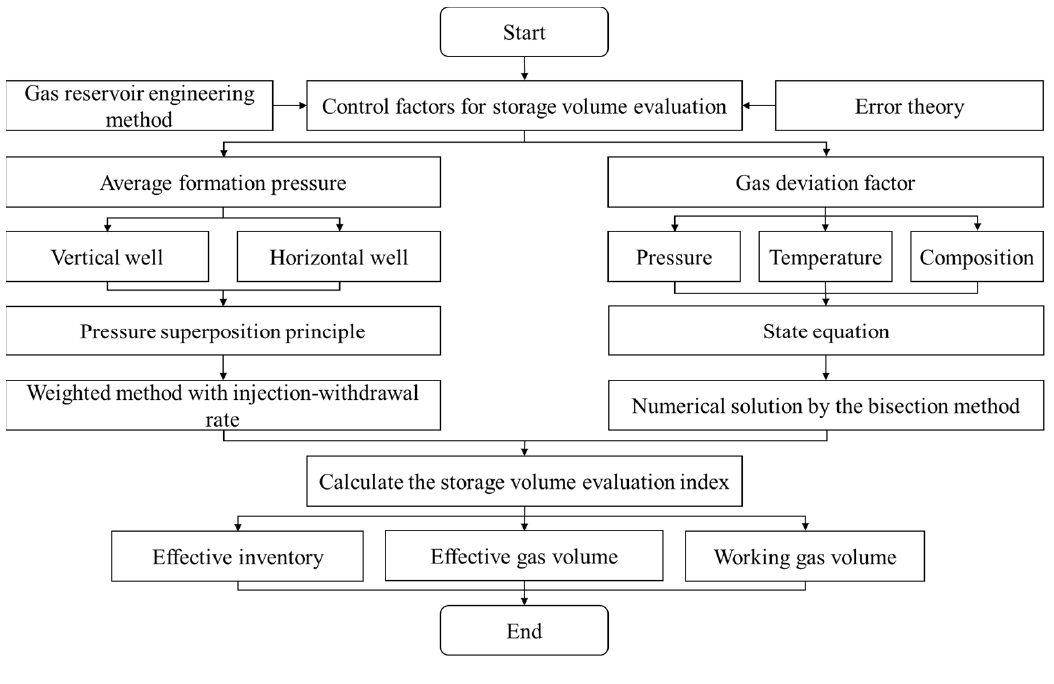
Figure 5. The flow chart for the performance evaluation method of the gas reservoir − type UGS.